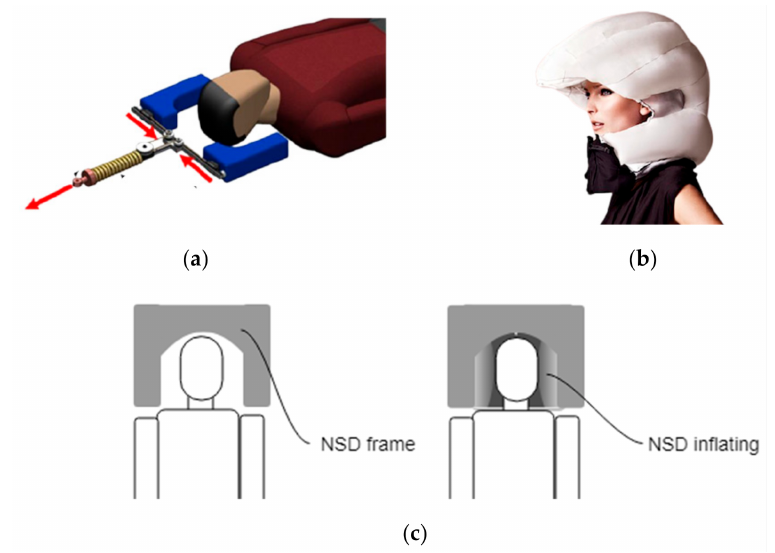
Figure 7. Several concepts of protecting the head from possible injuries. ( a ) The head support system proposed in [30,40] to immobilise the head during casualty extraction. ( b ) Hovding inflatable cycling helmet, as presented in [59,60], that protects the cyclist’s head during a crash. ( c ) Proposed neck securing device (NSD), using the inflatable mechanism proposed for the ResQbot 2.0 design. The requirement for the integration of the NSD in the stretcher bed (belt conveyor) system was that the NSD should be able to slide down along the bed to the ground and slide back up around the bed end. The NSD does not require a separate actuator for the sliding movement. The movement of the NSD relies on friction between the NSD and the conveyor belt. The NSD is placed on top of the conveyor and attached to linear guides on both sides of the NSD to constrain its movement only along the stretcher bed. Figure 8 illustrates the updated procedure to load casualties by means of the NSD system. This procedure is an extension of Step 4 in Figure 6.